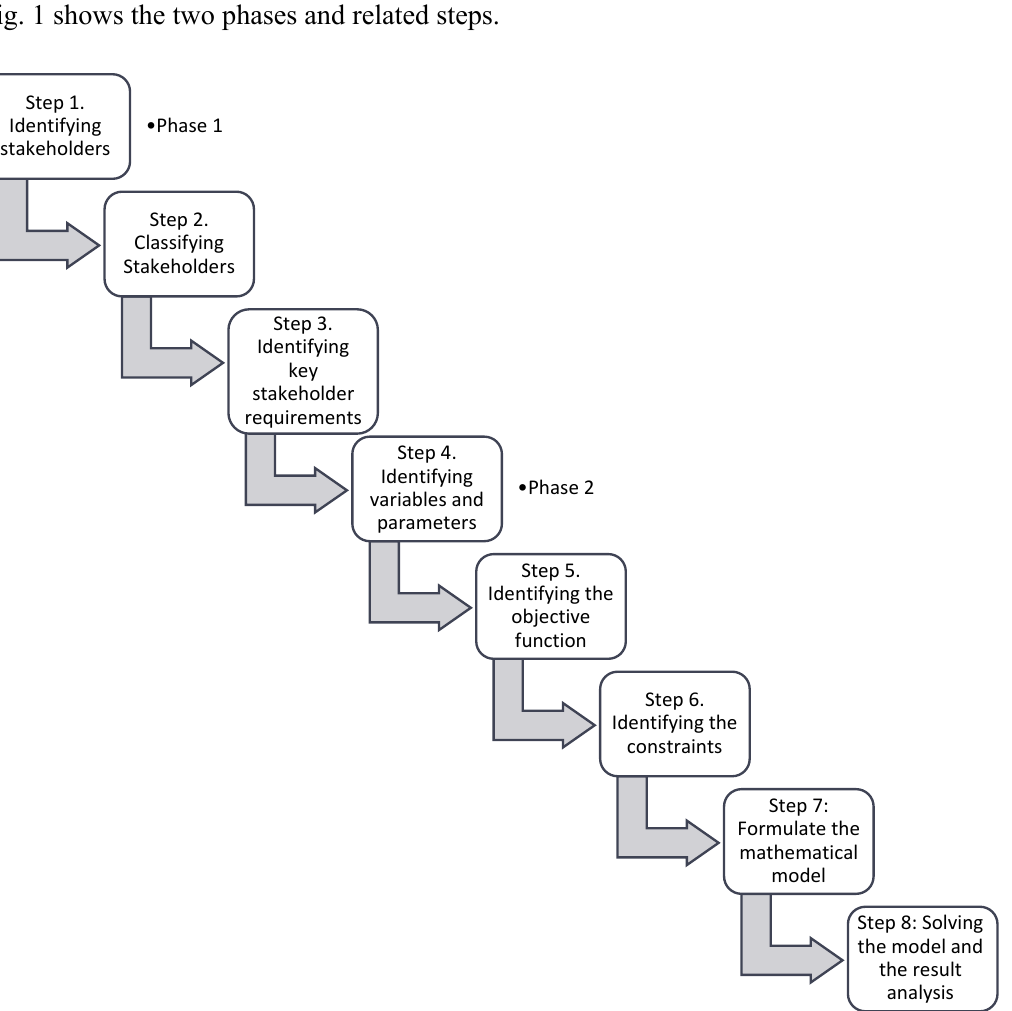
Fig. 1. Two main phases and research steps of the